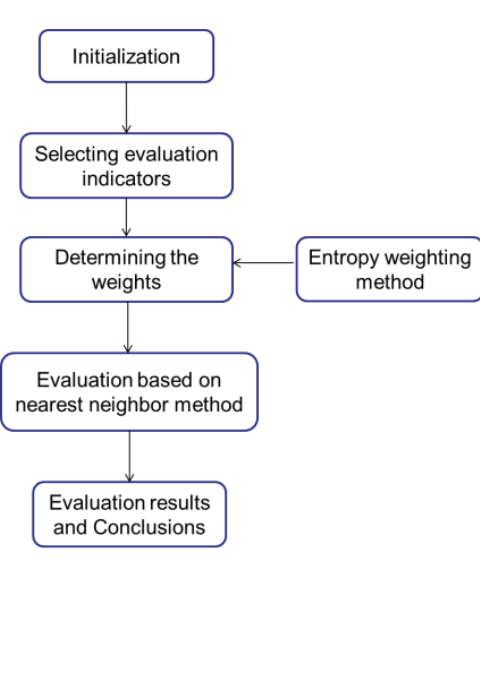
Figure 2. Evaluation model